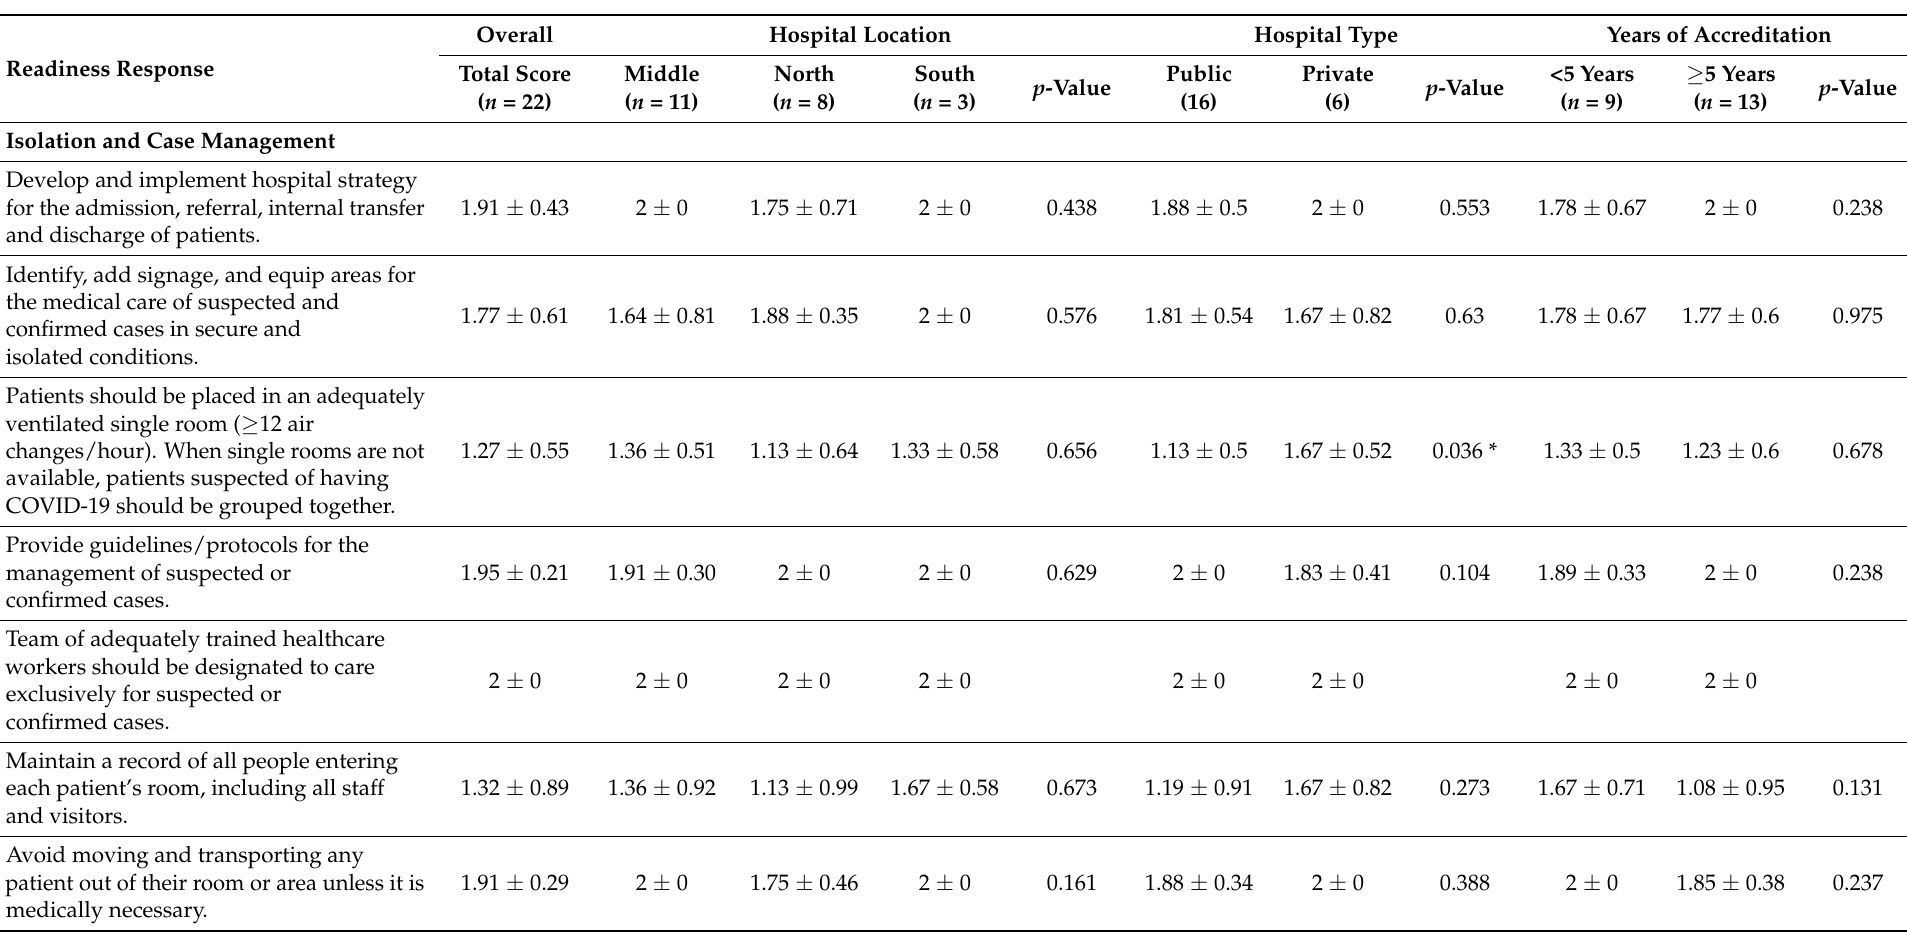
Table 7. Detailed average compliance score of participating hospitals according to response function stratified according to hospital location, type, and years of accreditation for response functions (isolation and case management, and infection prevention and